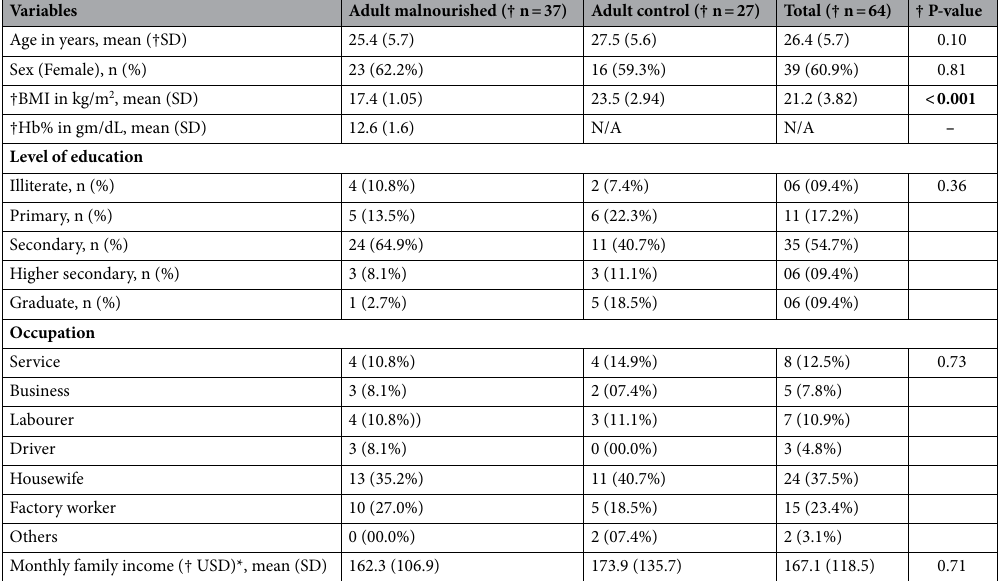
Table 1. Demographic characteristics of the malnourished and control adults. *1 USD = 85.07 BDT was used as conversion rate. † n Number of respondents, P-value Significance level, SD Standard deviation, BMI Body mass index, Hb% Hemoglobin, USD United States